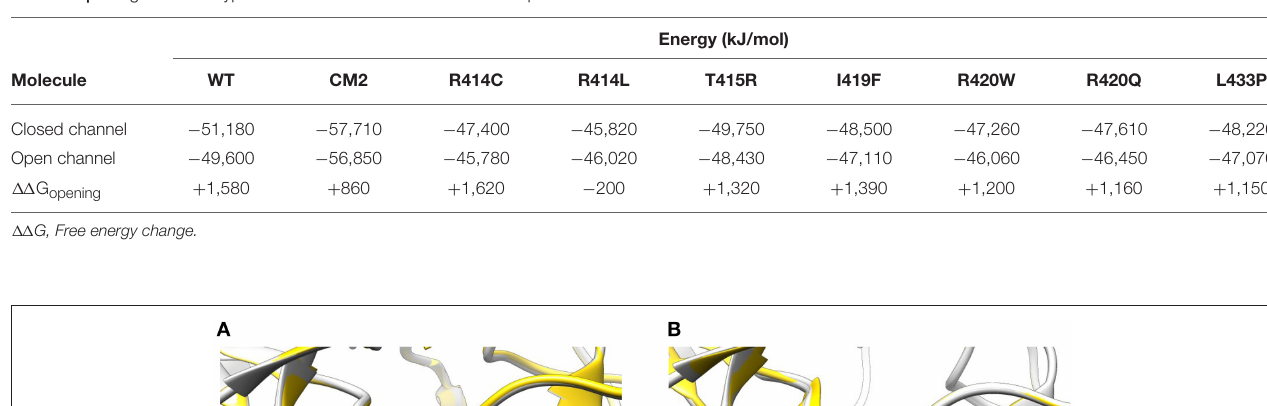
peptide-NTR interaction. This is in line with the observations of the effect of other RyR ligands, namely, cytosolic (Zahradnik et al., 2005) and luminal Ca 2 + (Tencerova et al., 2012), ATP (Tencerova et al., 2012), and of the peptide DP cpvtC from the central domain (Faltinova and Zahradnikova, 2013) that were shown to activate the ryanodine receptor by an allosteric